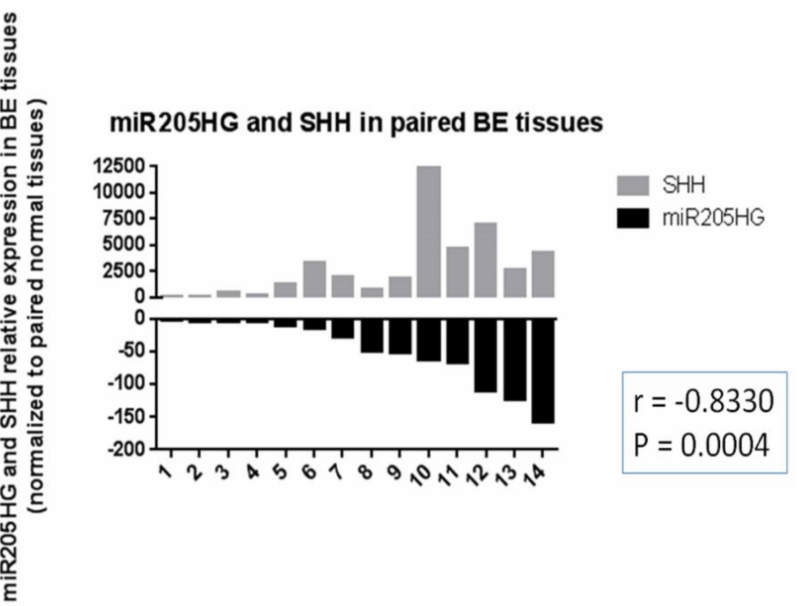
Figure 16. Upregulation of SHH and inverse correlation of miR205HG and SHH expression levels in BE tissues. Tissues from 14 patients with BE were tested by qRT-PCR. SHH was significantly upregulated relative to NE in all BE tissues studied (14/14, average fold-change 2913.0, paired t -test p -value < 0.0001). In addition, miR205HG and SHH expression levels were inversely correlated (r = − 0.83, p -value =